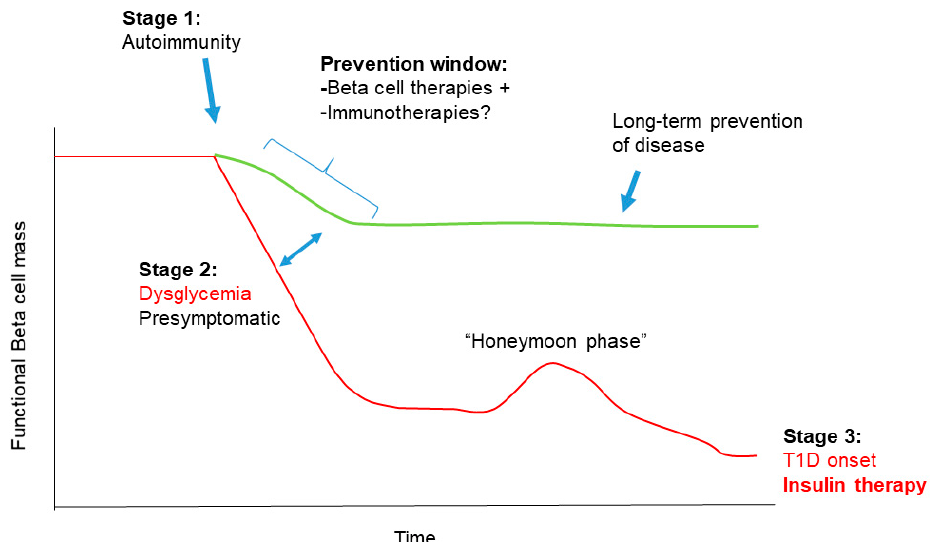
Figure 2. Combining beta cell therapy and immunotherapy for T1D prevention. There is a clear window for preventing T1D onset during stage 2, where seroconversion and dysglycemia are evident but patients are otherwise asymptomatic. The e ff ectiveness of beta cell-targeted therapies, such as drugs inhibiting UPR or targeting senescence could be synergistic with immunotherapy during this stage. Intermittent use and more targeted delivery of these treatments during this preventive window could a ff ord long-term prophylaxis against further loss of beta cell mass and function (green line), altering the typical trajectory of declining beta cell mass and function leading to T1D onset (red